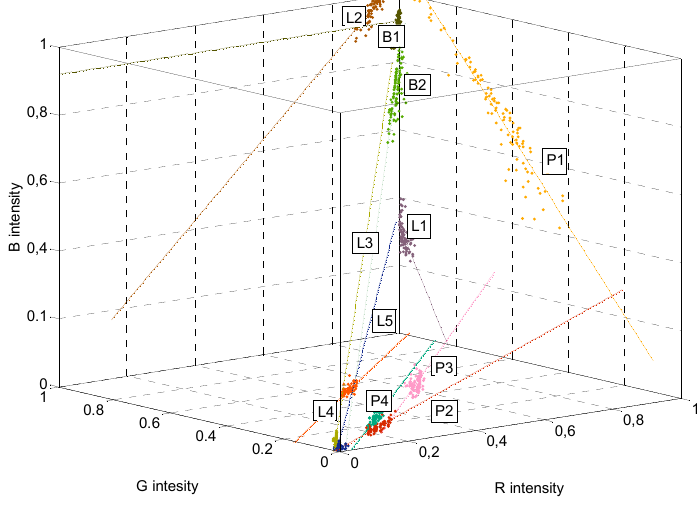
Figure 5. Linear color models proposed to detect red paraguayo